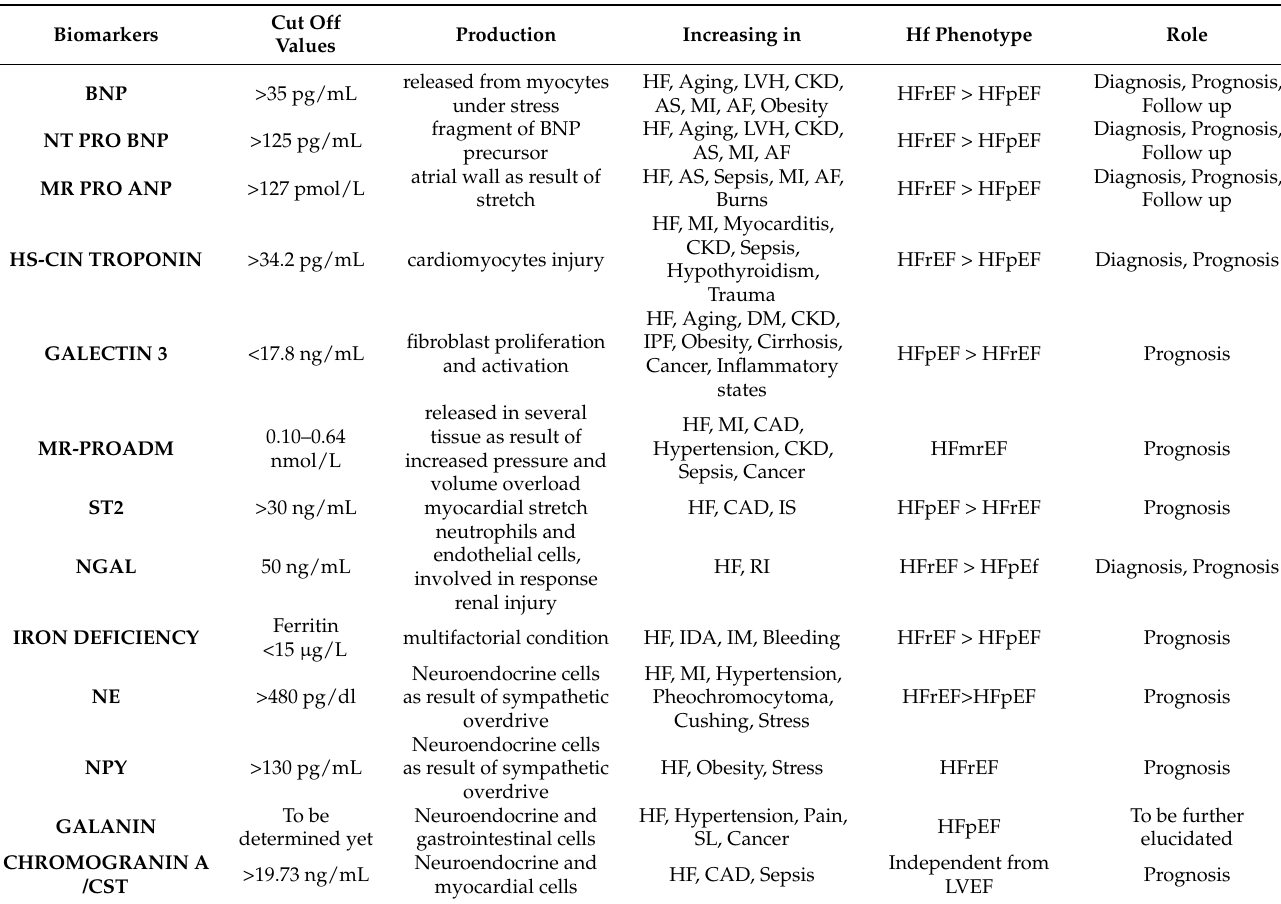
Table 1. Summary of the main HF